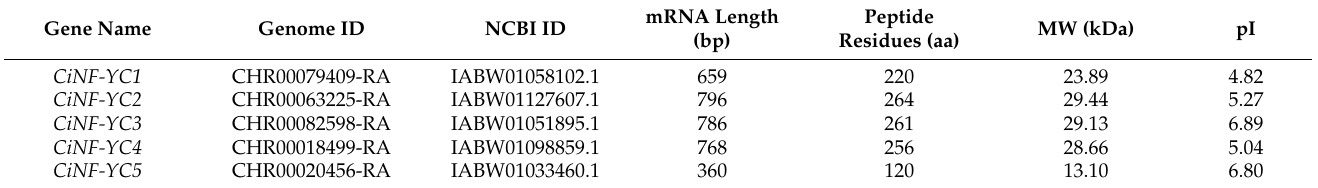
Figure 1. Multiple alignment and phylogenetic analysis for wild chrysanthemum NF-YC proteins. ( a ) Multiple alignments of full length of CiNF-YC proteins. The subunit interaction domain is represented. The alpha-helices (rectangles) and coils (black lines) are marked on the bottom. The required amino acids (required AA) are given on the bottom of the alignment. Conserved typtophan (W148) and the putative arginine (R)-aspartate (D) pairs were marked. ( b ) Phylogenetic analysis of NF-YC proteins in Arabidopsis thaliana and Chrysanthemum indicum ( (cid:78) ). Table 1. Basic information of the NF-YC gene family in chrysanthemum indicum .